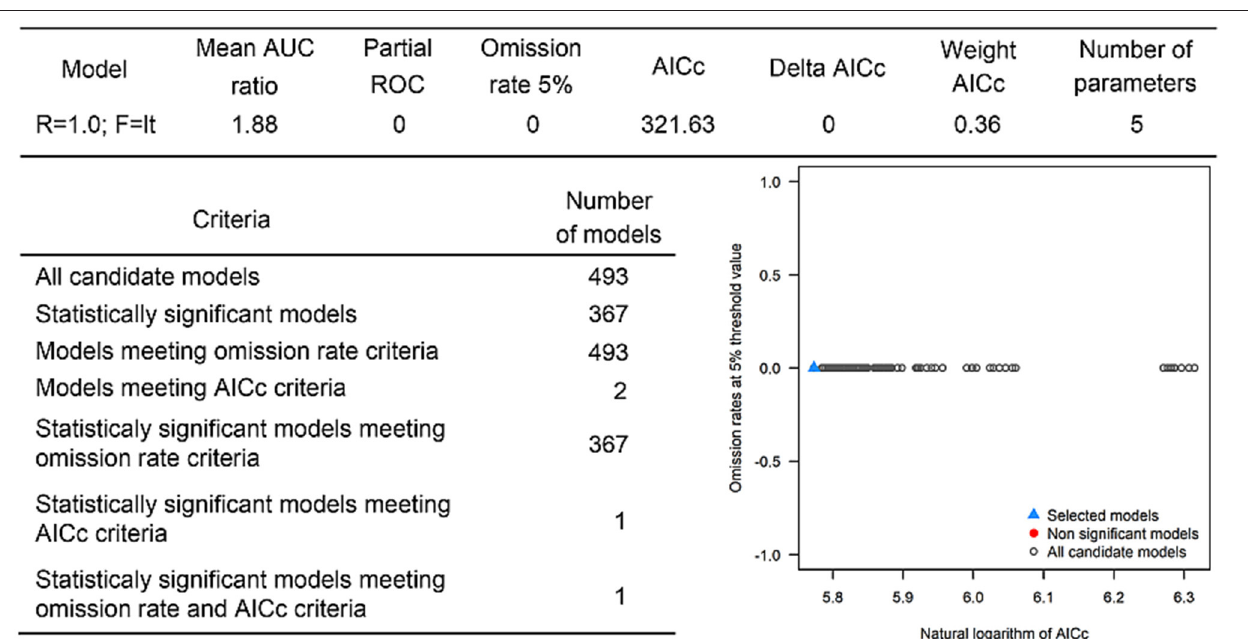
variable was the most influential (48.7%) in describing the risk area, followed by runoff (21.8%), evapotranspiration (11.6%), precipitation (10.2%), minimum temperature (4.7%), and soil moisture